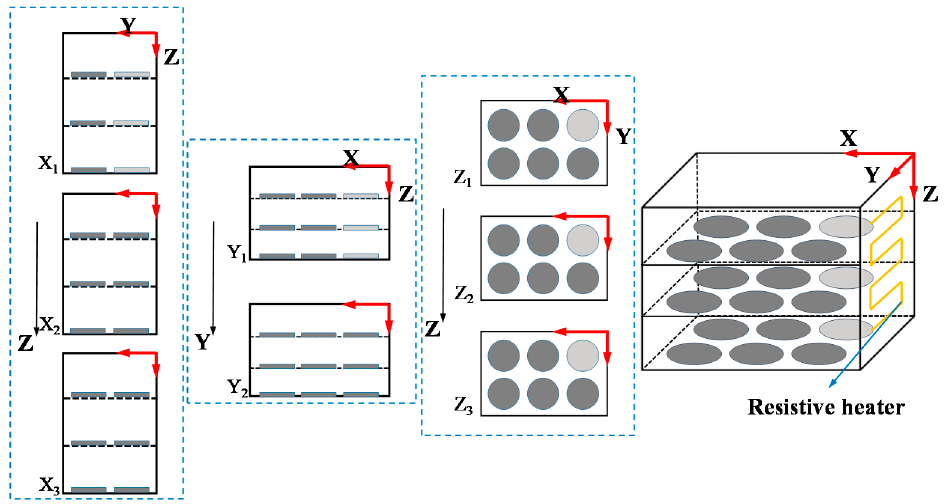
Figure 2. Schematic map of the positions of the mastic plates in the oven.